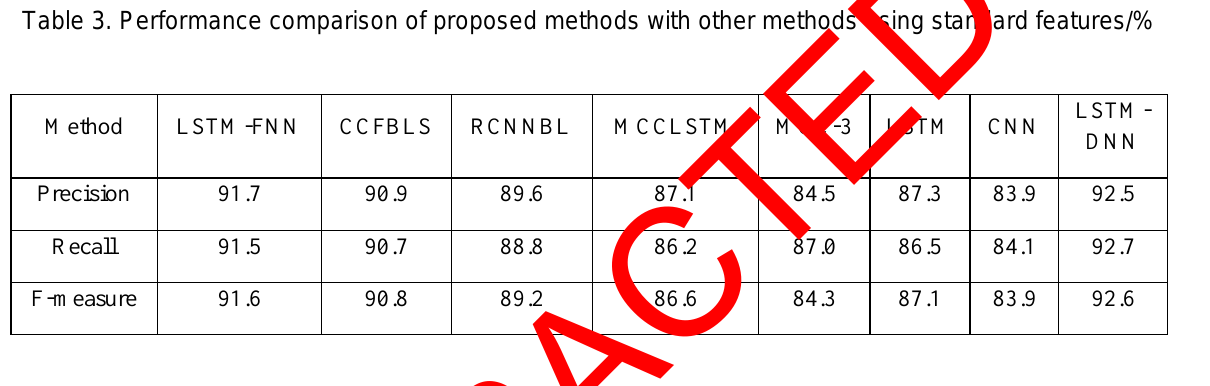
Table 3. Performance comparison of proposed methods with other methods using standard features/%